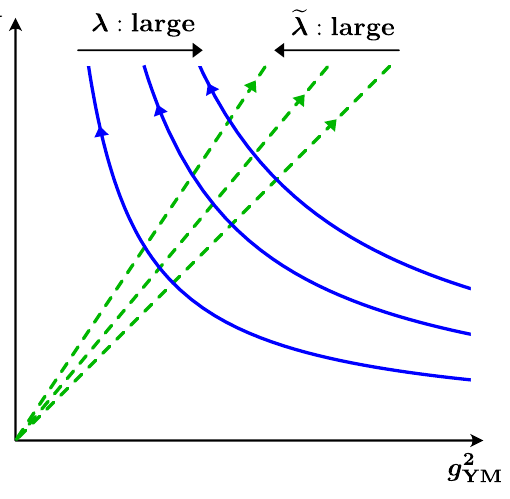
Figure 1. The blue solid lines show slices in the ’t Hooft limit, and the green dashed lines show slices in the dual ’t Hooft limit. For large but finite N , the strong ’t Hooft coupling limit meets the strong dual ’t Hooft coupling limit in the very strong coupling